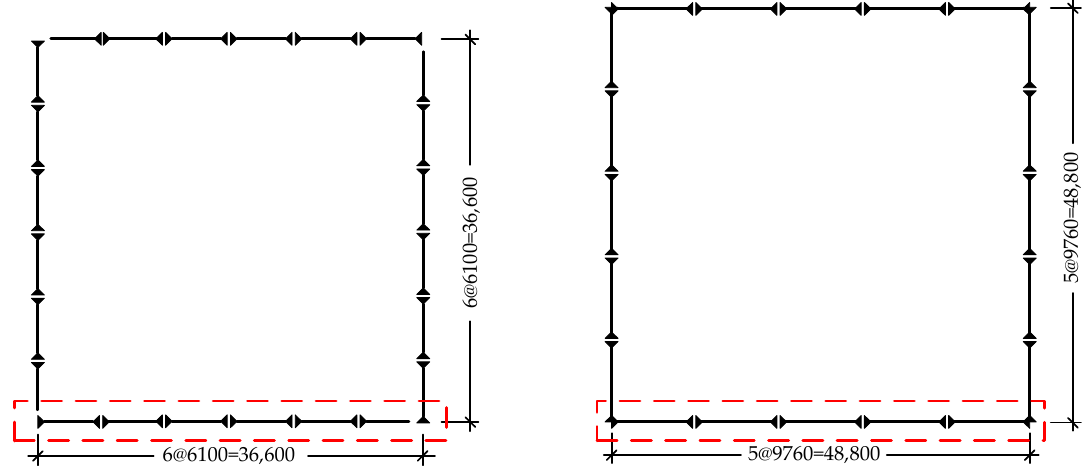
Figure 10. Floor plan of the 6F and 13F buildings.